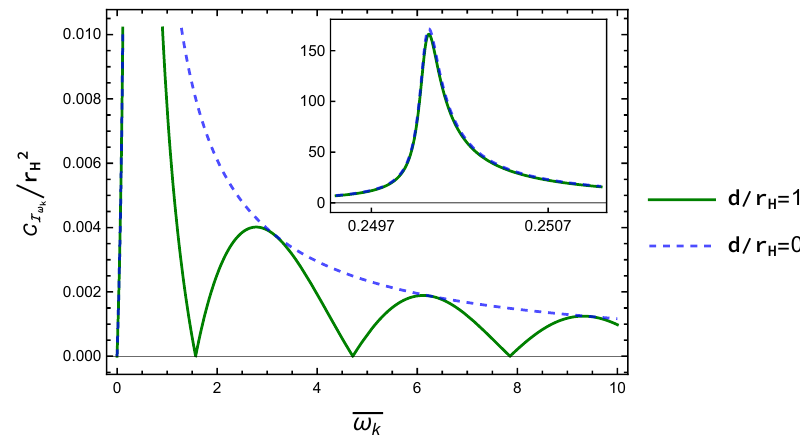
= ( |I ) /r 2 , signifying the concurrence, is plotted /r 2 ε ωk | − I j ωk H H ωk = r for fixed detector transition energies k H ω k ∆ E B = 0 . 5 . The other parameter is fixed at d/r H